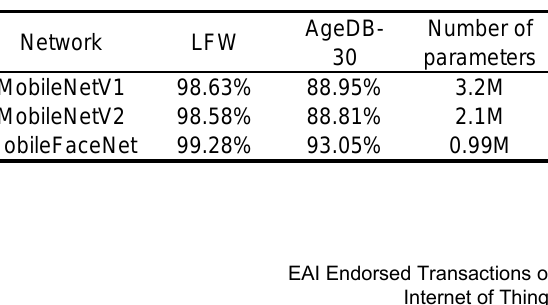
Table 2. Comparison of MobileFaceNet